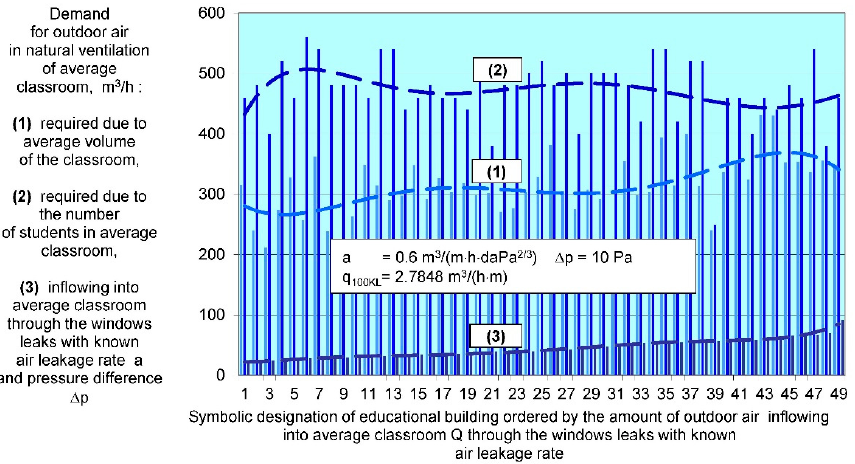
Figure 11. The quantity of air flowing into the classroom from the outside through new windows that meet the technical requirements- a = 0.6 m 3 /(m h daPa 2/3 ), corresponding to q 100KL = 2.7848 m 3 /(h ⋅ m).